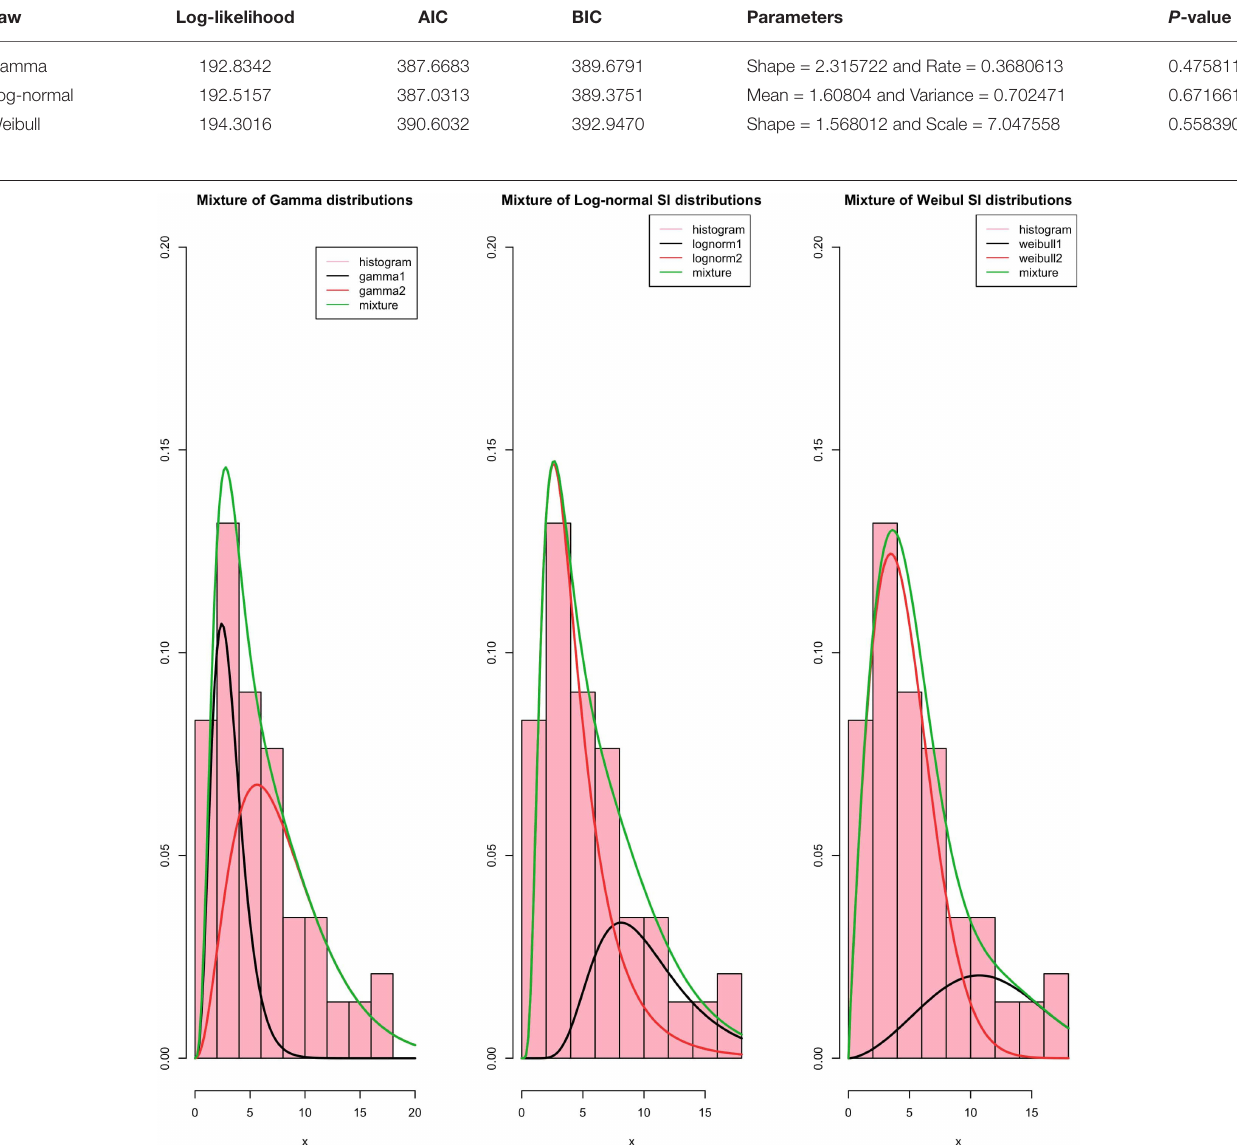
TABLE 2 | Log-likelihood, AIC, BIC and parameters with the MLE.